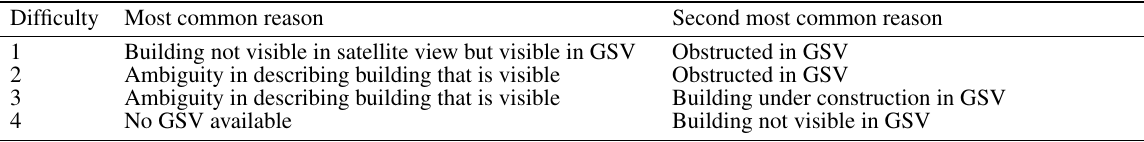
Table 1. The predominant reasons by the four difficulty levels in interpreting SVI for extracting information on buildings. Advantages